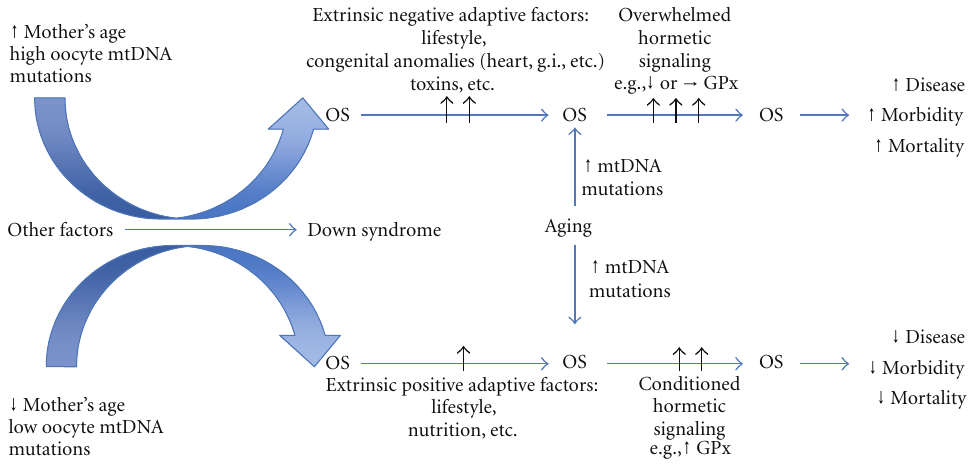
Figure 3: Modulation of DS phenotypes by oxidative stress and mitochondrial factors. Fetal oxidative stress (OS) levels could be determined by the mother’s age and initial mtDNA mutation levels in oocytes. Besides the genetic/intrinsic factors that create the genomic instability in DS, environmental factors and lifestyle modulate the initial OS further. Since all these factors that play a role in the level of OS di ff er individually, the OS-related changes will also be observed in variation. Simply, while the low level of OS could initiate the positive adaptive response by activating proper defense signaling, high level of OS will start destructive signaling where the adaptive response could not be able to accommodate the clearance of the damage. More positive factors (e.g., lifestyle, advantageous genetic background—mitochondrial haplotype, APOE, BDNF genotype, etc.—and nutrition) will feed the adaptive response positively, while negative factors (e.g., congenital defects, sedentary lifestyle, genotypes, etc.) will increase the OS further. In both low and high levels of initial OS conditions, aging will a ff ect this process negatively by increasing OS, such as increasing mtDNA mutation accumulation and decline in mitochondrial functions. Under increasing OS conditions with aging, individuals with DS will be prone to develop more morbid conditions and prone to death depending on their initial adaptive response signaling. In other words, negative factors will lead to earlier clinical manifestations of age-related conditions, while positive adaptations (e.g., conditioned hormetic signaling) may support normal cellular and systemic functions for longer periods of